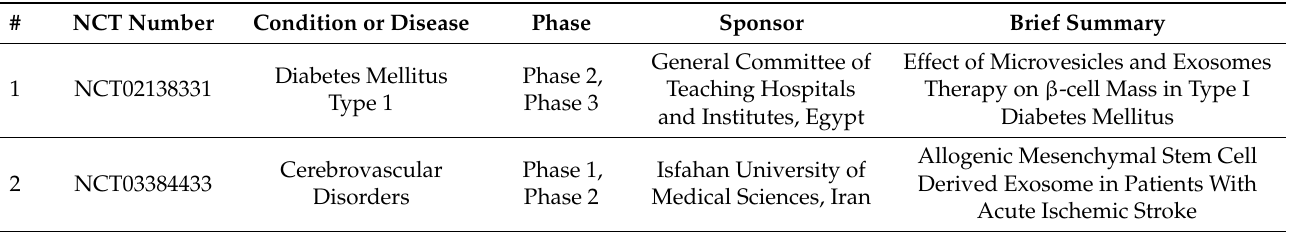
Table 1. Clinical trials of MSC-derived